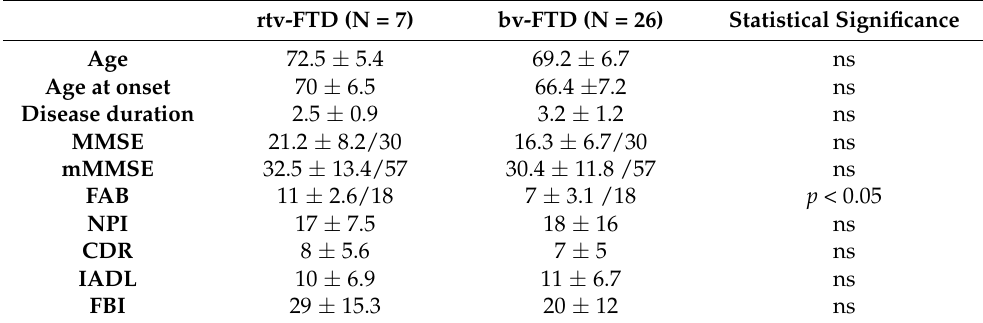
Table 2. Demographic and neuropsychological data in right temporal variant of frontotemporal dementia (rtv-FTD) and behavioral variant of frontotemporal dementia (bv-FTD) patients in our initial evaluation. rtv-FTD (N = 7) bv-FTD (N = 26)